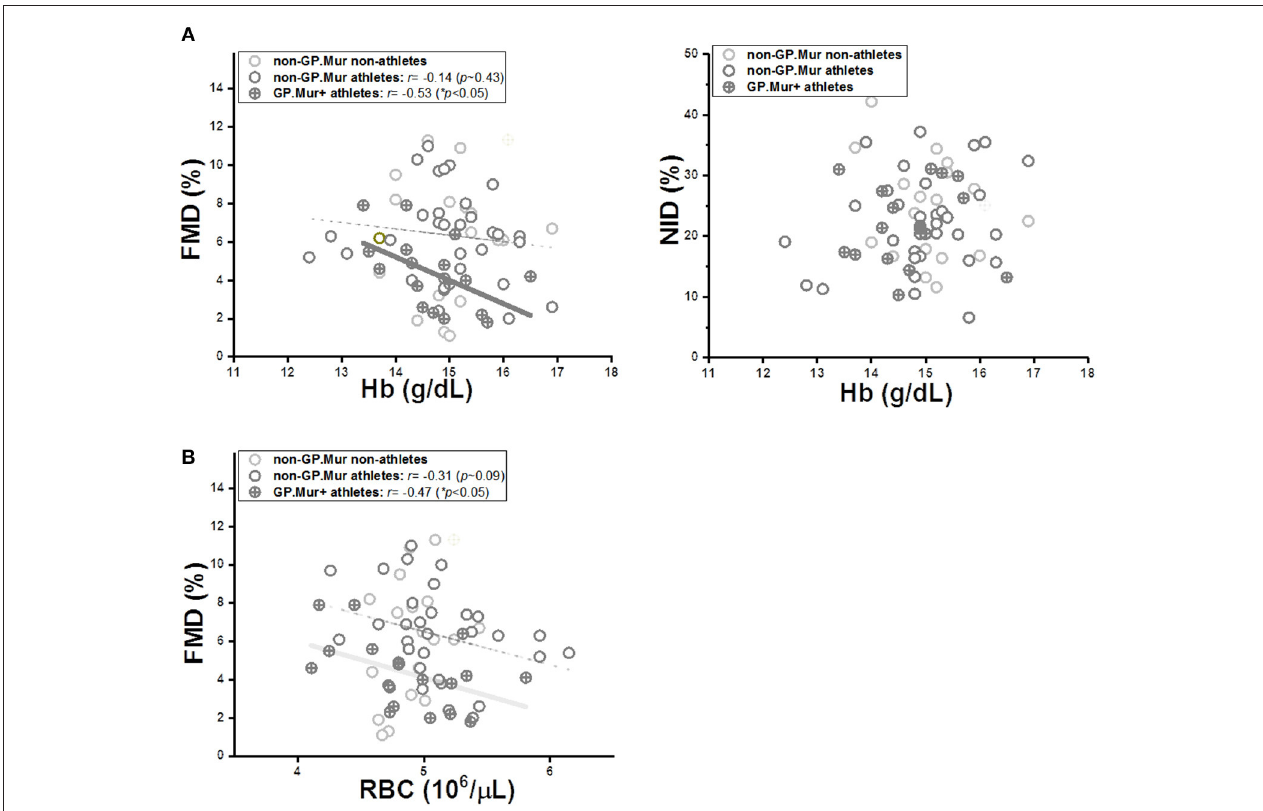
FIGURE 3 | The limiting effect of intraerythrocytic Hb on FMD was more significant in GP.Mur + athletes (cross circular symbols) than in the non-GP.Mur control subjects (empty circular symbols). (A) LEFT: Linear regression analyses revealed a significant inverse correlation between Hb and FMD in GP.Mur + athletes, which was less obvious in non-GP.Mur athlete and non-athlete subjects (GP.Mur: Pearson’s r = − 0.53 (* p < 0.05); non-GP.Mur: weak correlation). RIGHT: Intraerythrocytic Hb exerted no specific effects on NID for GP.Mur + or non-GP.Mur subjects. (B) The dependency of FMD on RBC count was similar for both GP.Mur + and non-GP.Mur groups. Solid thick lines represent significant linear fitting; thin, dotted lines represent poor fitting ( p >